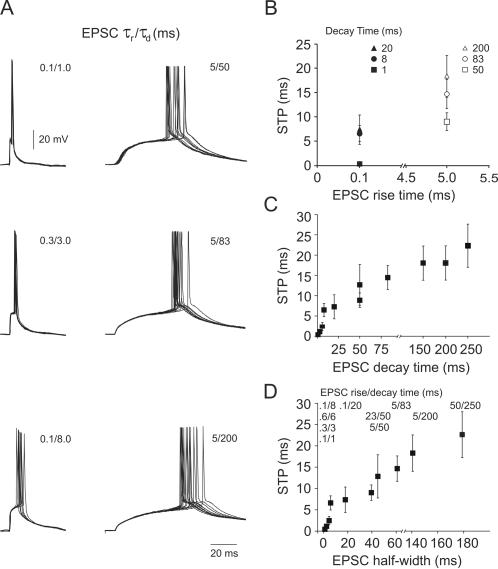
Physiological EPSCs induce spike responses with a temporal precision that is mostly determined by EPSC decay time. A, Action potentials induced by the repeated somatic injection of physiological compound EPSCs. Each plot shows 12 traces of raw data superimposed. The left column shows spike responses to compound EPSCs with fast kinetics (τrise/τdecay 0.1/1, 0.3/3 and 0.1/8 ms). The right column shows responses to compound EPSCs with slow kinetics (τrise/τdecay 5/50, 5/80 and 5/200 ms). B, Mean STP is plotted as a function of EPSC rise time. Note that the same rise time could be combined with up to three different decay times to produce different EPSC shapes. C, STP plotted as a function of EPSC decay time constant. Same data as shown in B. D, STP plotted as a function of EPSC width at half amplitude. Same data as shown in B.